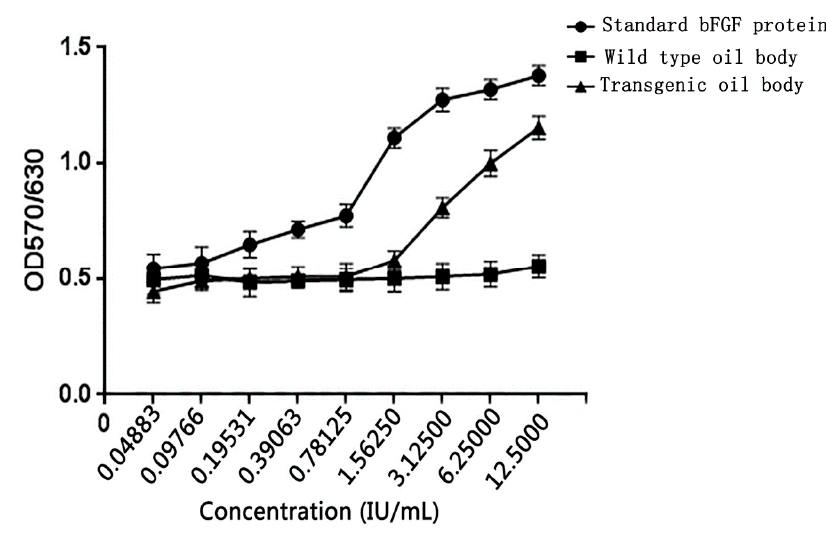
Figure 7. Dose–response curves for proliferation activity. Increase of NIH/3T3 fibroblast cells were expressed as the percentage increases in absorbance (570/630 nm).